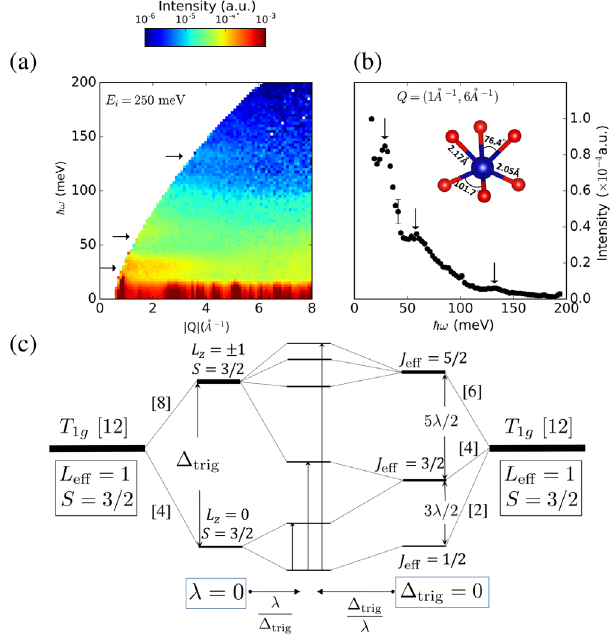
FIG. 2. (a) Neutron scattering intensity plot on a log scale as a function of energy (in meV) and momentum transfer (in Å − 1 ) ¼ 250 meV. The data were for an incident neutron energy of E i collected at T ¼ 5 K. Since there is no directional dependence of the crystal field excitations, the scattering intensity is averaged over all orientations, and only the magnitude of momentum transfer is shown. (b) Momentum integrated in- tensity for 1 . 0 Å − 1 < j Q j < 6 . 0 Å − 1 plotted as a function of energy transfer. The inset shows trigonally distorted oxygen octahedra around each Co 2 þ ion. Horizontal and vertical arrows in panels (a) and (b), respectively, mark the positions of observed crystal field excitations. (c) Schematic crystal field ¼ 1 and levels for Co 2 þ (three t 2 holes, with total L g eff ≪ λ (right), S ¼ 3 = 2 ) in the regimes λ ≪ Δ (left) and Δ trig trig where λ is the SOC and Δ is the trigonal distortion. Vertical trig arrows correspond to the sharp transitions seen in panels (a) and (b). The numbers in the square brackets denote degeneracies of the states. (See Supplemental Material [31] for a further description of the